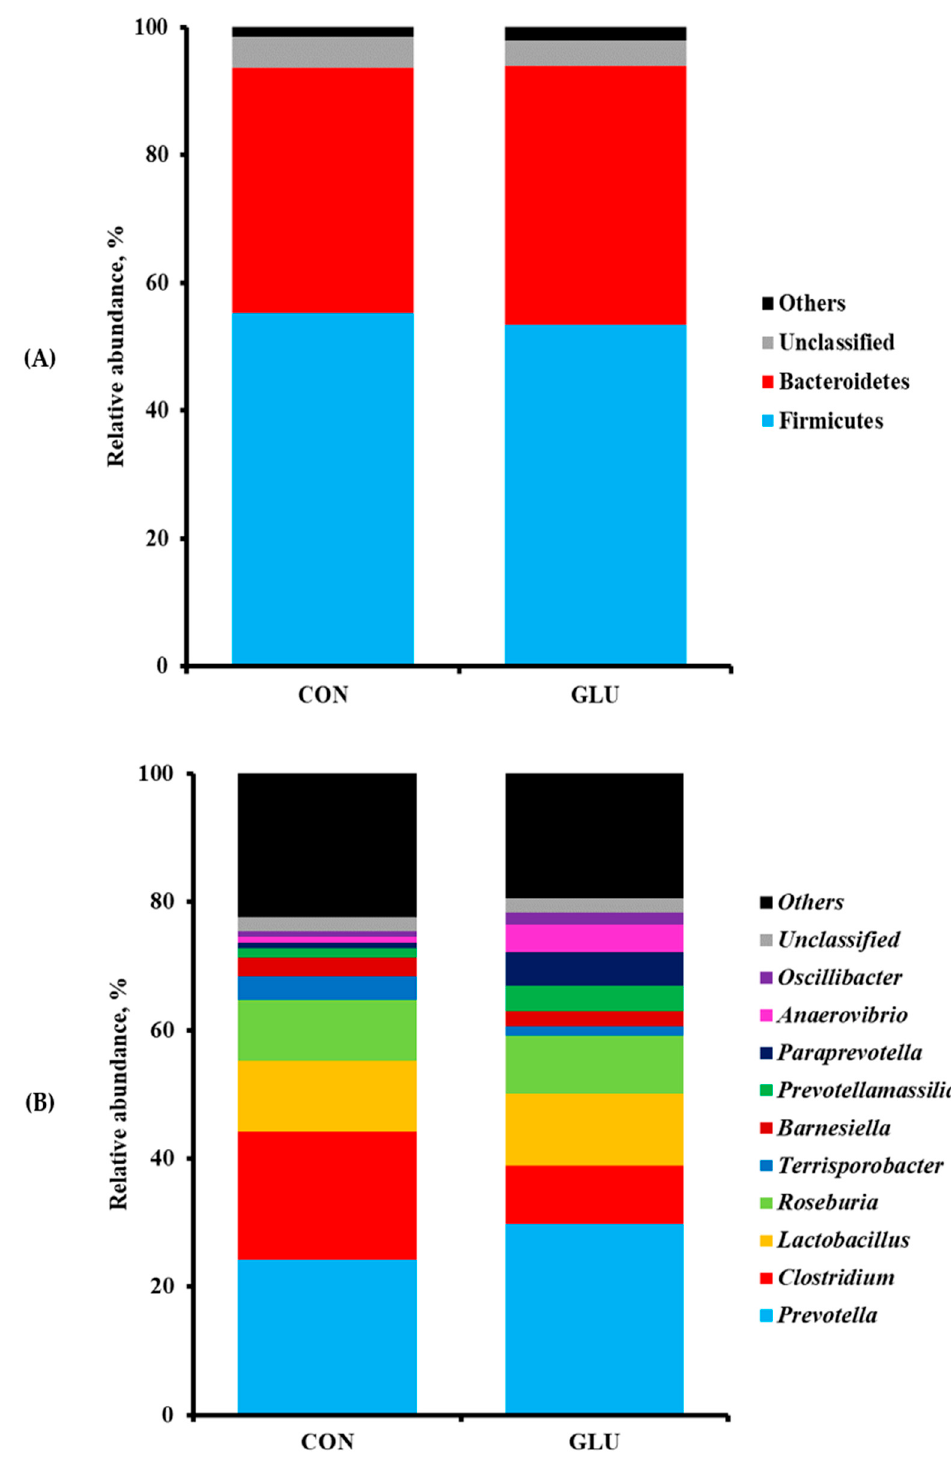
Figure 3. Taxonomic classification of total bacteria at phylum ( A ) and genus ( B ) levels retrieved from pooled DNA amplicons for each treatment group ( n = 3). The proportion of fecal microbiota of weaned pigs less than 1% was not included. CON = a typical weaner diet; GLU = CON with 0.5% glutamic acid.